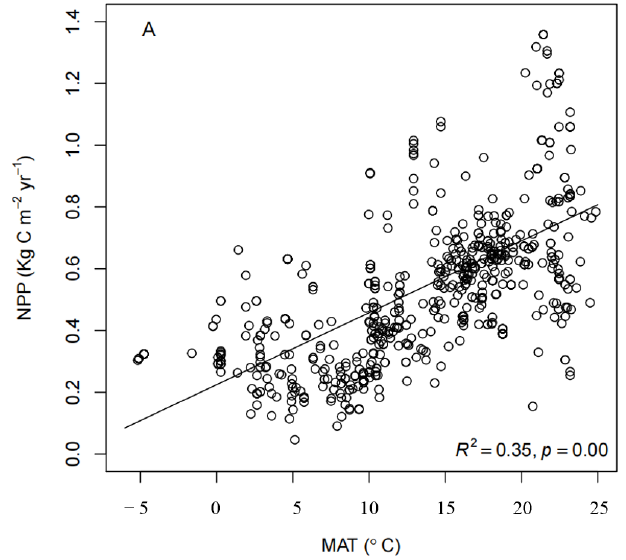
Figure A15. Sensitivity of NPP (kg C m − 2 year − 1 ) of subsoil (0.2–1 m) to changes in MAT (°C) obtained from linear regression.